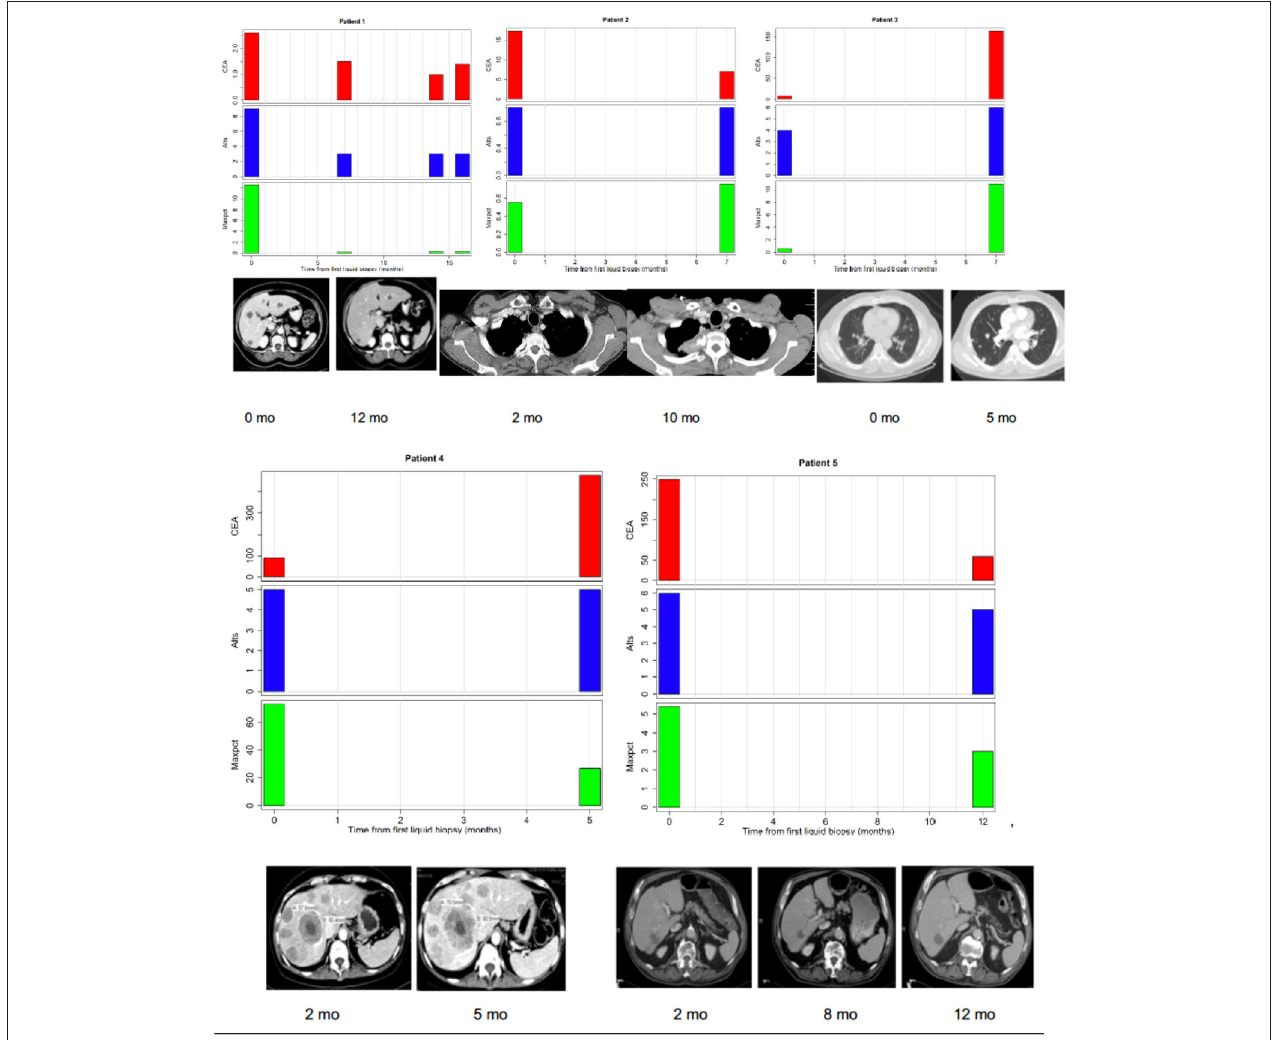
FIGURE 3 | Correlations between tumor burden as assessed by radiographic imaging (CT scans) or CEA (tumor marker) and liquid biopsy mutation parameters (alts or number of alterations/number of mutated genes and maxpct or maximal allele frequency of mutated allele). (Top Left) Maxpct, CEA, and alts follow a downward trend as disease on CT scan improves. Center: With growth of mediastinal mass on CT, note rise in maxpct, CEA, and alts. (Top Right) As lung disease worsens on CT, maxpct, CEA, and alts increase. (Bottom Left) Despite increasing tumor on CT scan and rising CEA, maxpct did not rise. Liquid biopsy did contain APC and TP53 mutations, indicating presence of ctDNA. (Bottom Right) Liver metastases decreased between 1/2017 and 7/2017 and then increased in 11/2017. Allele freq. low (2–4%) probably due to low disease burden on